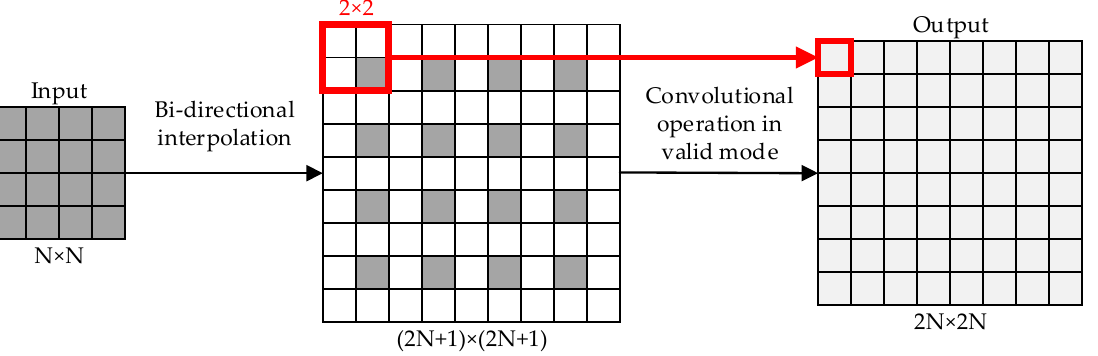
Figure 2. Bilinear with the valid mode (N = 4 in this example). The size of the input feature map is N × N . We expand the original size of the feature map to (2 N + 1) × (2 N + 1) and set the value of intervals with 0. Then, we use a 2 × 2 kernel to carry out the convolutional operation in the “valid” mode (padding = 0 and step = 1), which could obtain a new 2 N × 2 N output.